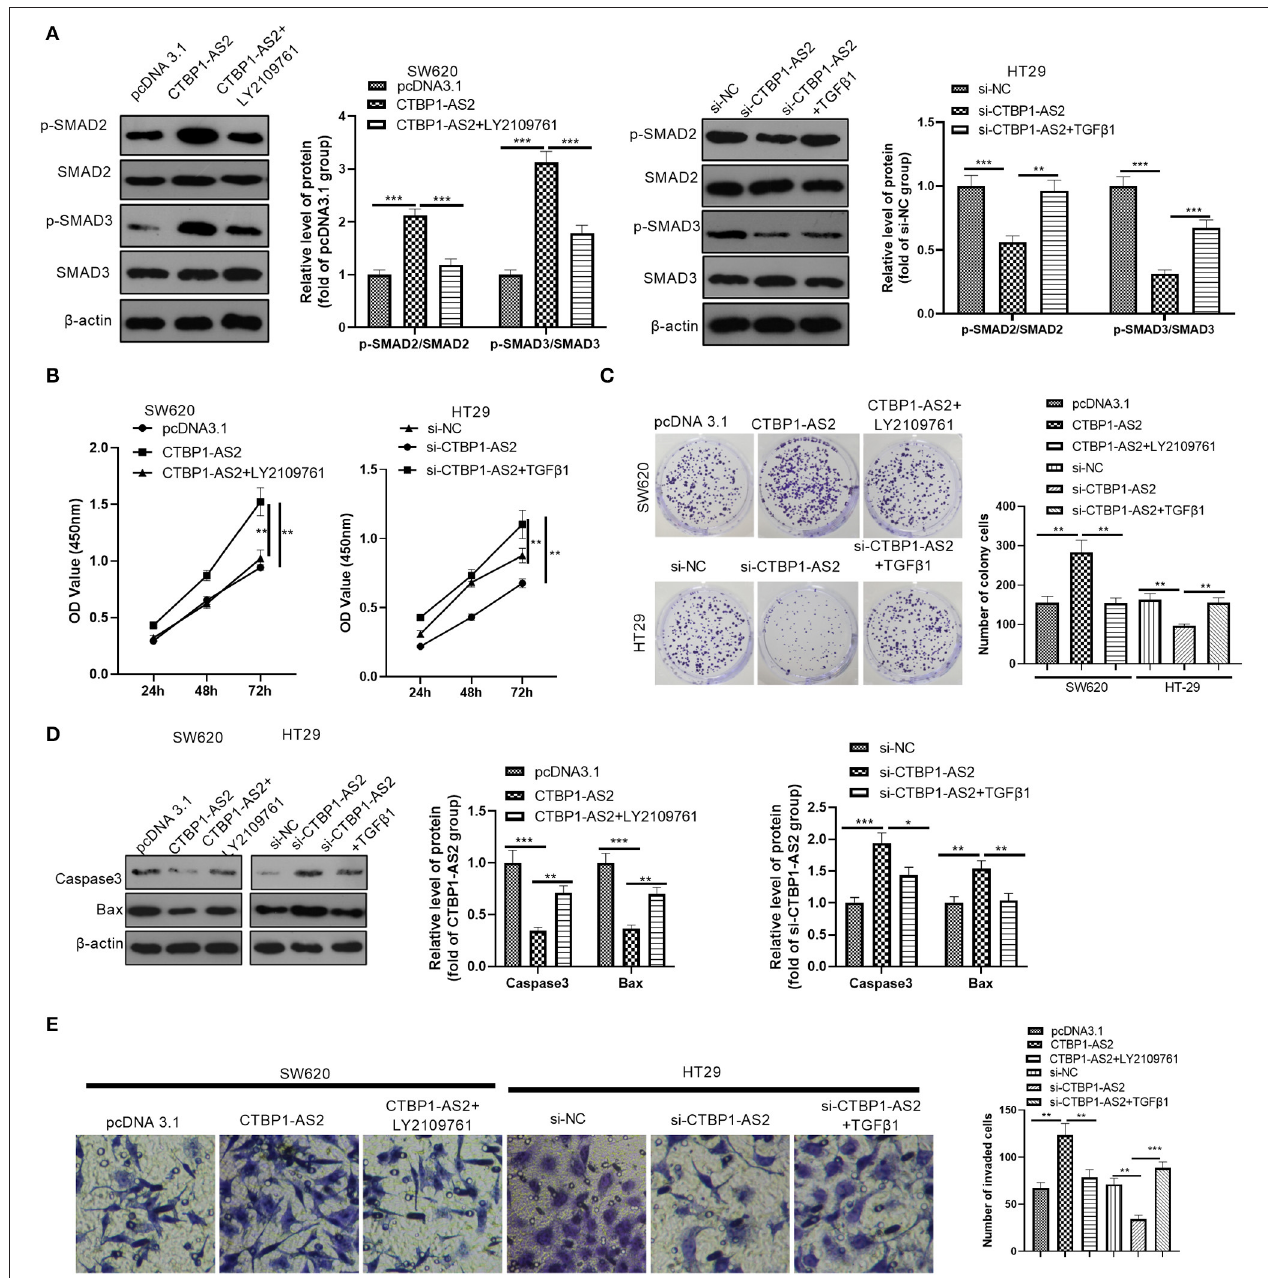
FIGURE 4 | Effect of interference with the TGF- β /SMAD2/3 pathway on CTBP1-AS2 function. (A) Use of human recombinant TGF- β 1 (100ng/ml) to activate the TGF- β /SMAD2/3 pathway in HT29 cells transfected with si-CTBP1-AS2, and LY2109761 (5 µ M) to inhibit the TGF- β /SMAD2/3 pathway in SW620 cells transfected with CTBP1-AS2 overexpression plasmids for 4h. Evaluation of the phosphorylation and total protein levels of SMAD2/3 by Western blotting. (B) Examination of cell proliferation of SW620 and HT29 cells using CCK-8 assay. (C) Detection of cell proliferation of SW620 and HT29 cells using colony formation experiments. (D) . Use of Western blotting to measure the expression of apoptosis-related proteins caspase-3 and Bax in tumor cells in SW620 and HT29 cells. (E) . Use of the Transwell method to measure cell invasion of SW620 and HT29 cells. * p < 0.05, ** p < 0.01, *** p < 0.001. N = 3. Abbreviations: CCK-8, cell counting kit-8; TGF- β /SMAD2/3, transforming growth factor- β /small mothers against decapentaplegic 2/3.